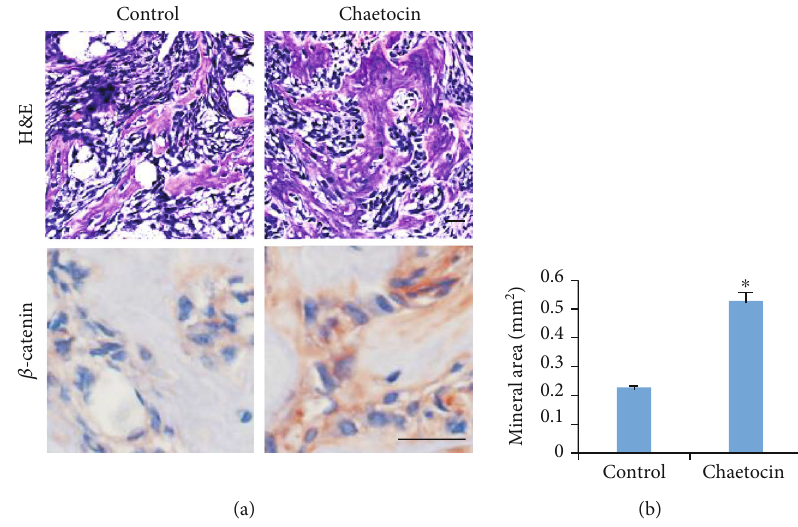
Figure 4: Chaetocin promotes MSC-mediated ectopic bone formation. (a) H&E staining results show more bone tissues from MSCs treated with Chaetocin compared with control. IHC results showed more nuclear β -catenin signal in MSC treated with Chaetocin compared with control. Scale bar: 50 μ m. (b) Quanti fi cation of the bone area from MSCs treated with Chaetocin and control. Quanti fi cation data is expressed as means ± s : d : of three independent experiments ( ∗ p < 0 : 05